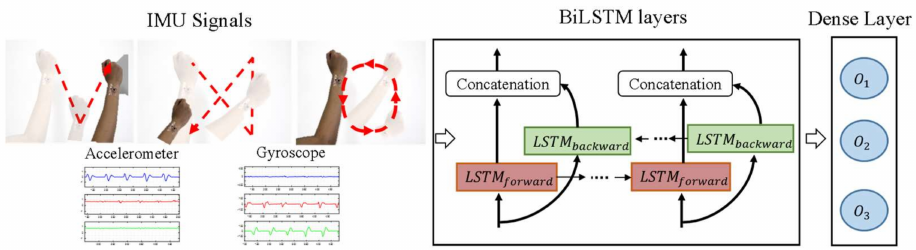
Figure 4. Hand gestures classifier based on a recurrent neural network (RNN) with bidirectional long short term memory